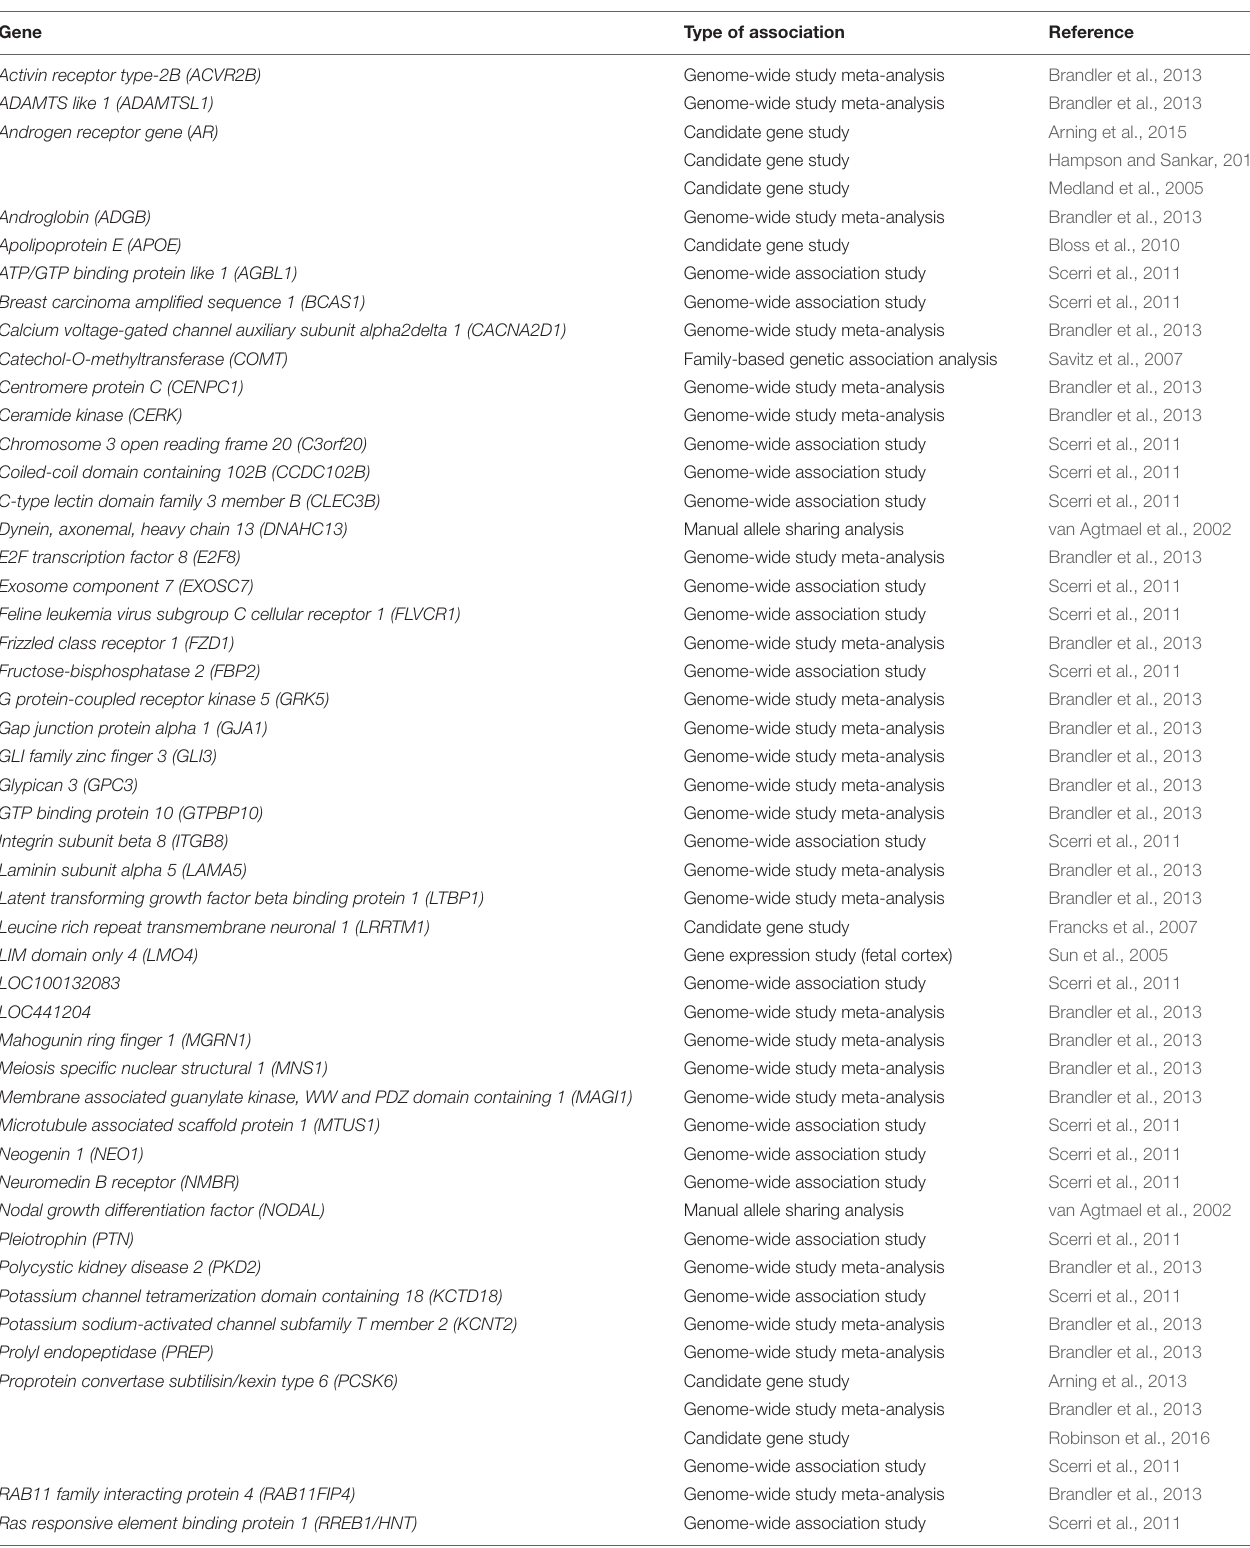
TABLE 1 | Identified genes involved in handedness